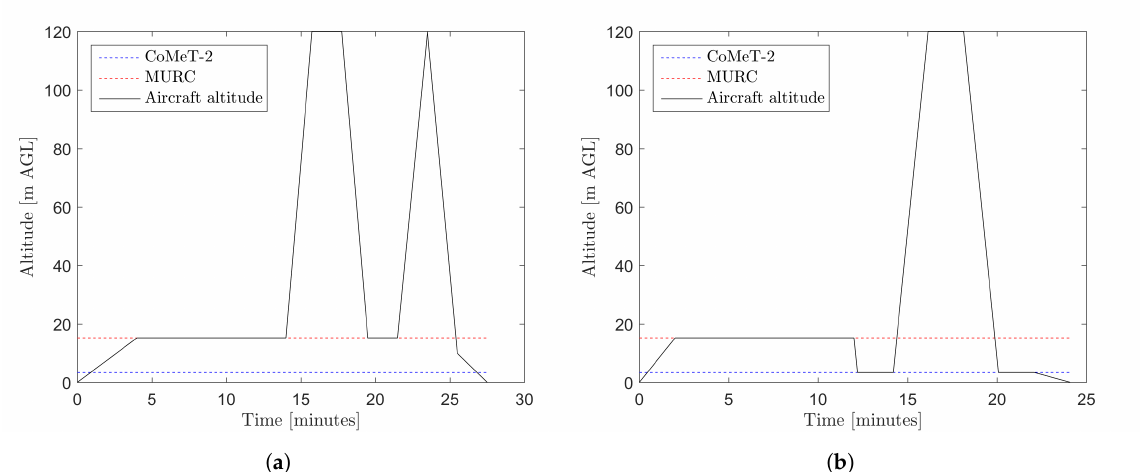
Figure 3. Example flight profiles. ( a ) Fixed-Wing; ( b )